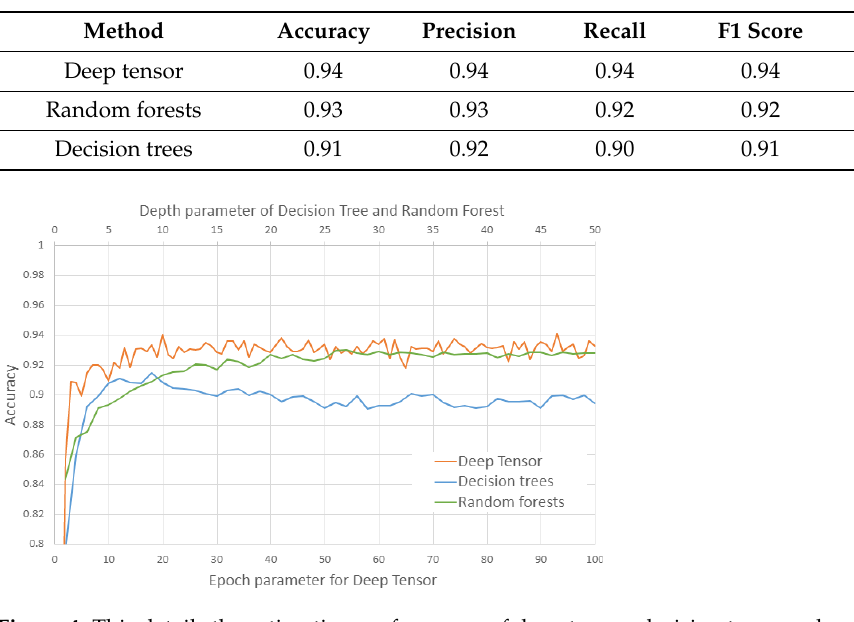
Figure 4. This details the estimation performance of deep tensor, decision trees, and random forests. The horizontal axis is the epoch parameter for deep tensor, and the depth parameter for decision trees and random forests. We varied the epoch or depth parameter and considered the highest estimation to be the performance of each method. These results are averages of a five-fold